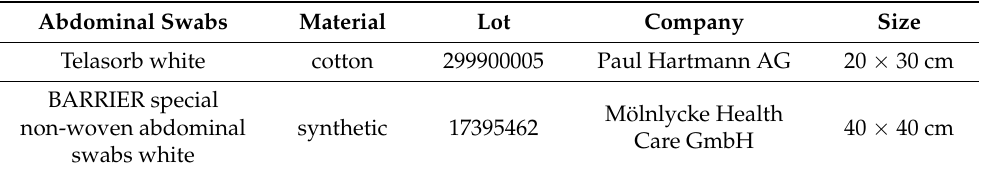
Table 1. Overview of the abdominal swabs used to compare the pyrogenicity between cotton and synthetic abdominal swabs using the MAT. Abdominal Swabs Material Lot Company Size Telasorb white cotton 299900005 Paul Hartmann AG 20 × 30 cm BARRIER special non-woven abdominal synthetic swabs white